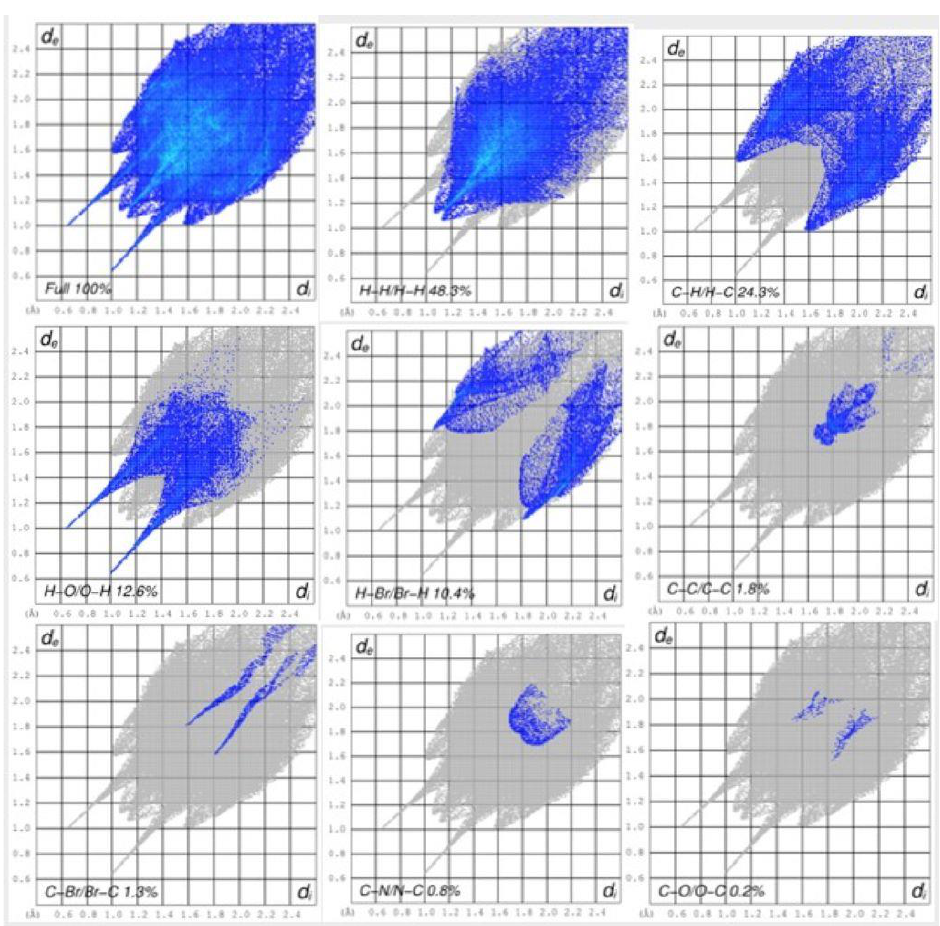
Figure 4. Full and partial 2D plots (fingerprint) for 3a , showing the percentages of interatomic con- tacts.